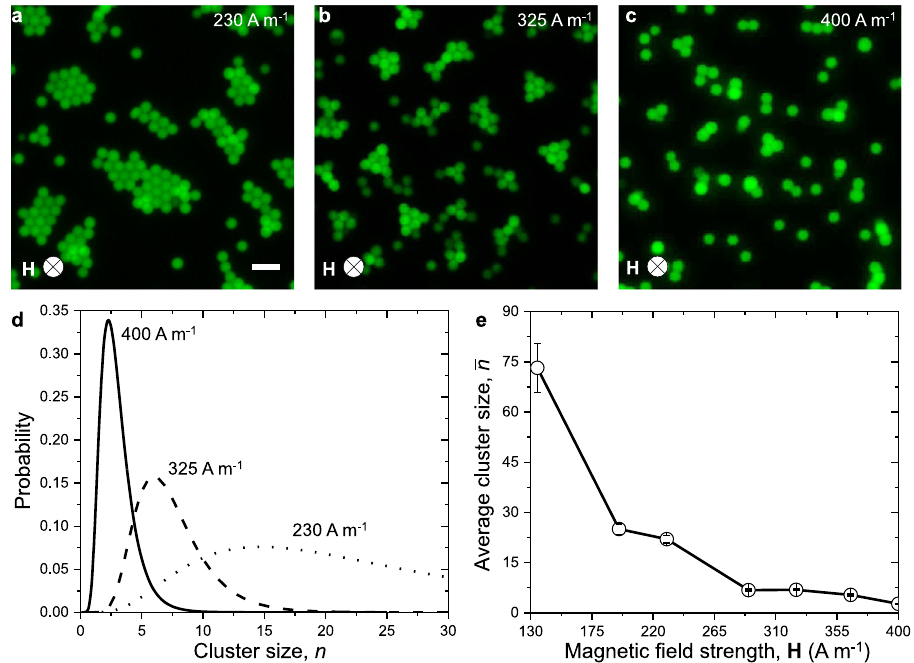
Fig. 6 Control and distribution of cluster size. Colloidal clusters assembled via depletion attraction and magnetic repulsion with magnetic fi eld strengths of a 230 A m − 1 , b 325 A m − 1 , and c 400 A m − 1 . Scale bar: 5 μ m. d Distribution of cluster sizes at different magnetic fi eld strengths. The y-axis indicates the probability of microparticles to be assembled in a cluster of size n. The value of the applied magnetic fi eld, H (A m − 1 ) is provided next to the corresponding curve. e Average cluster size decreases with increasing strength of the external magnetic fi eld. Error bars indicate the experimental standard deviation.